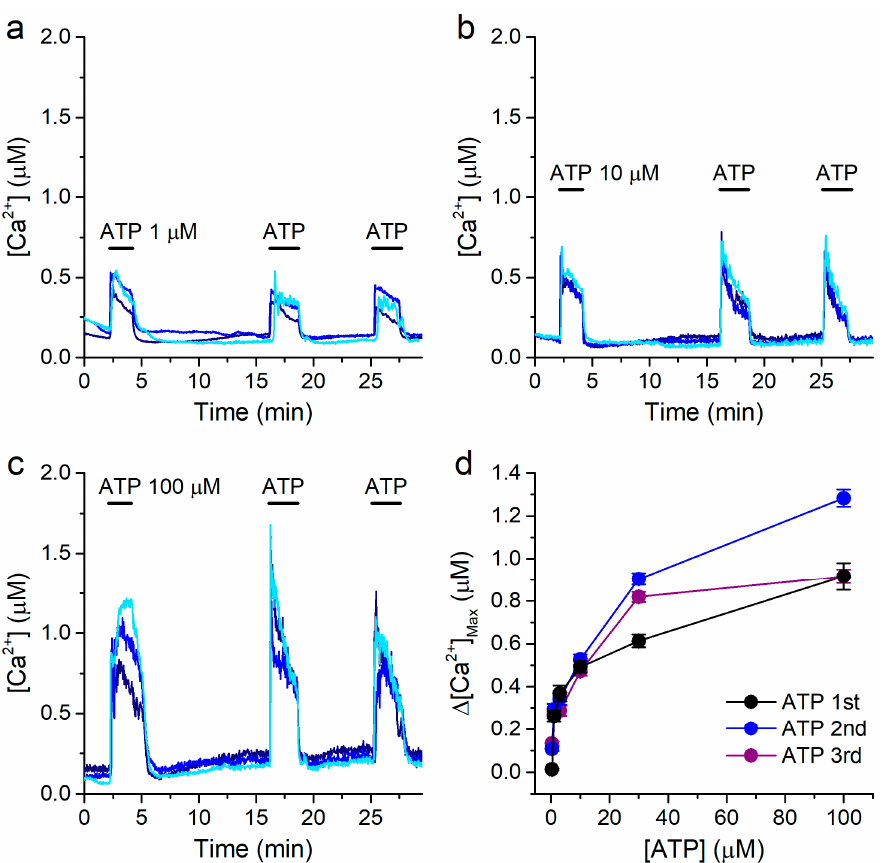
Figure 1. Extracellular ATP induces concentration-dependent responses in 16HBE cells. ( a – c ) Exam- ples of intracellular [Ca 2+ ] traces showing the responses to extracellular ATP applied at 1 μ M ( a ), 10 μ M ( b ) or 100 μ M ( c ), using a standard Krebs solution. ( d ) Concentration dependence of the ampli- tude of the responses to the 1st (black), 2nd (blue) and 3rd (purple) applications of ATP. The data are represented as mean ± s.e.m. ( n = 179, 59, 75, 96, 278 and 128, for ATP 0.3, 1, 3, 10, 30 and 100 μ M, respectively).